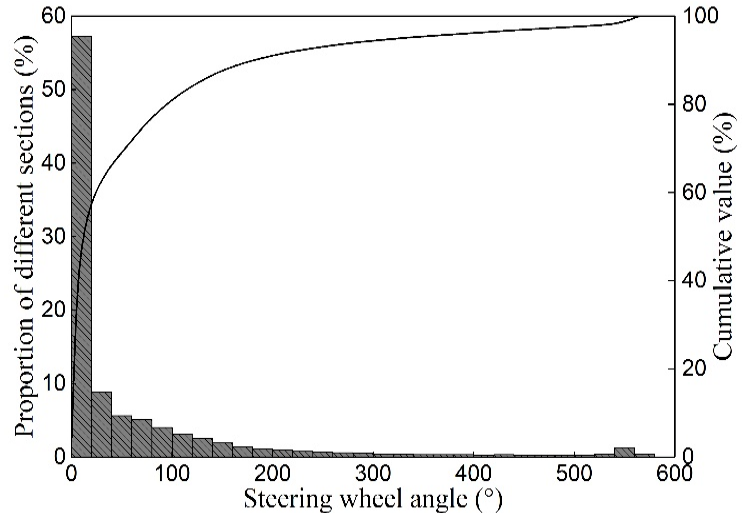
Figure 8. The distribution characteristic of steering wheel angle.